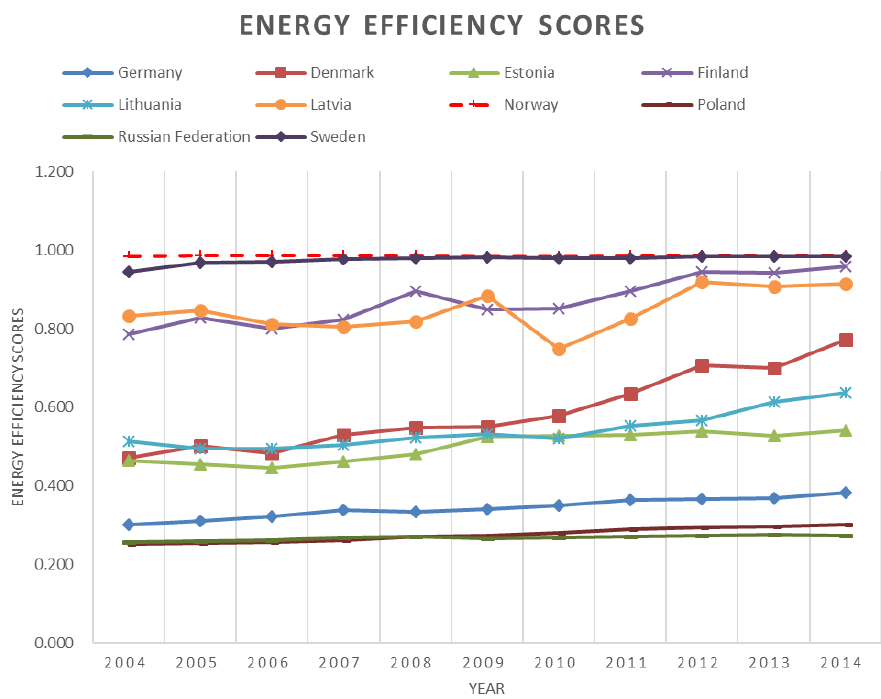
Figure 1. Energy efficiency scores in the Baltic Sea region.